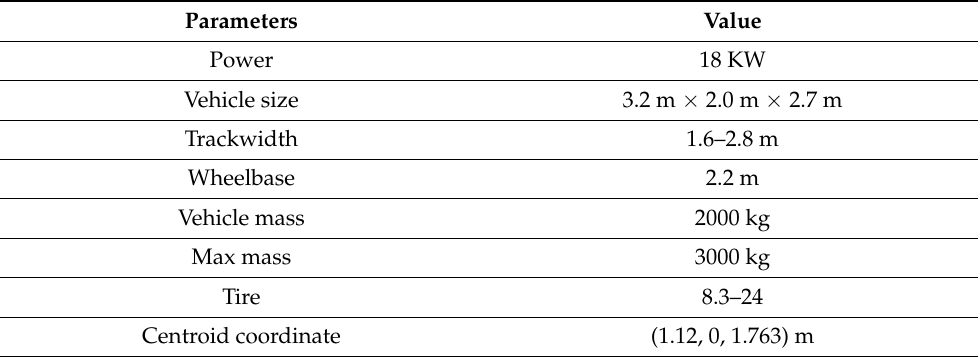
Table 1. Main parameters of the experimental